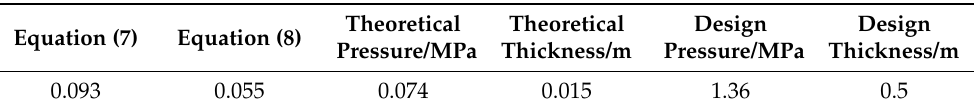
Table 7. Calculated lining pressure and